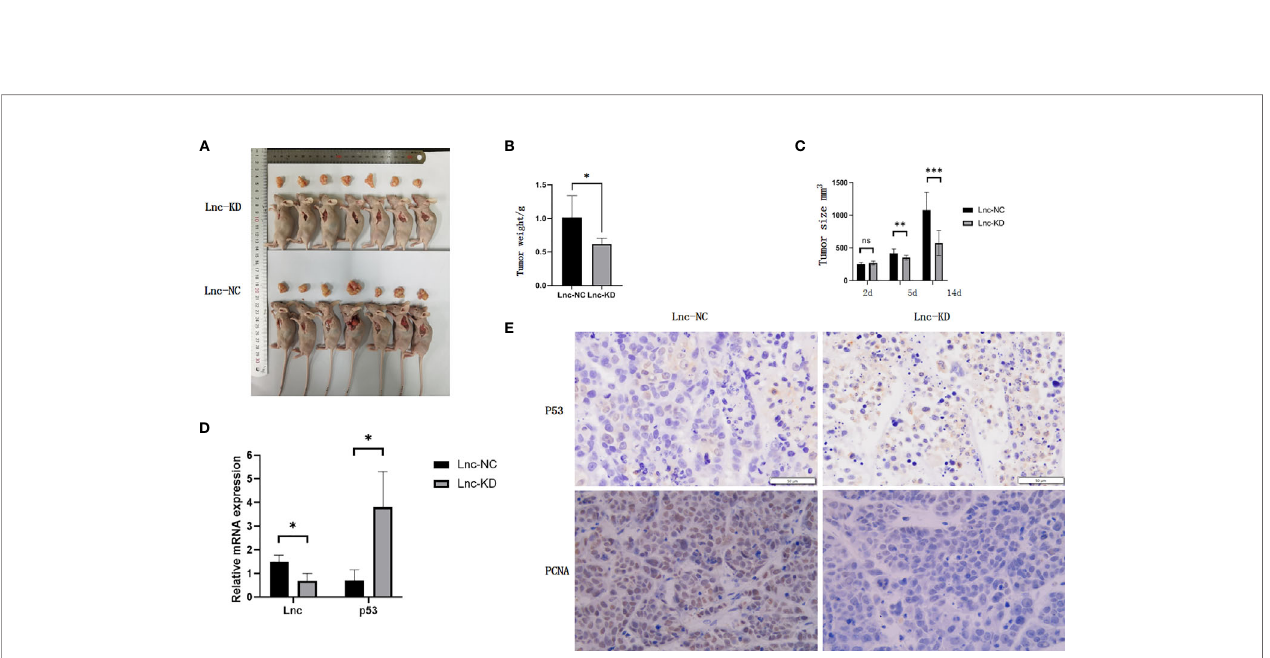
FIGURE 5 | Knockdown of lncRNA AC007639.1 inhibits the growth of tumor xenografts in nude mice. (A) The size of HepG2 xenografts using HepG2-LNC-KD or HepG2-LNC-NC cells at 14 days; (B) Weight of xenografts at collection; (C) Xenografts growth monitored in mm 3 ; (D) Relative AC007639.1 and p53 expressions (normalized to b -actin) in xenografts with HepG2-LNC-KD or HepG2-LNC-NC cells; (E) p53 and PCNA immunohistochemistry in xenograft tissues ( fi eld of view: 200x). Brown colored cells were positive for P53 or PCNA, respectively. *p < 0.05, **p < 0.01, ***p < 0.001; ns, not statistically signi fi cant.